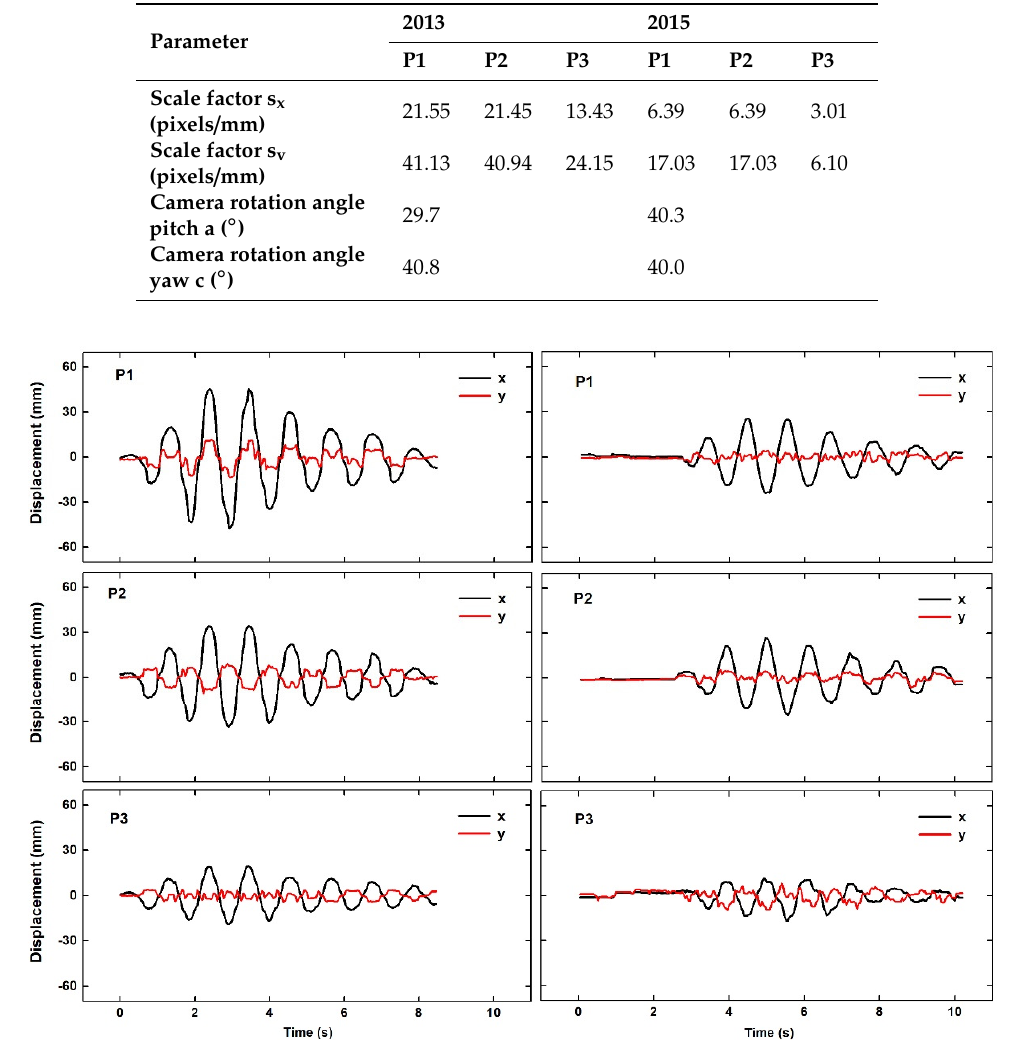
Figure 4. Summary of the computed lateral deflections (axis x) and the spurious longitudinal deflections (axis y) indicating the noise level in the measurements. Differences in the amplitude of displacements in 2013 and 2015 indicate the difference in excitations.